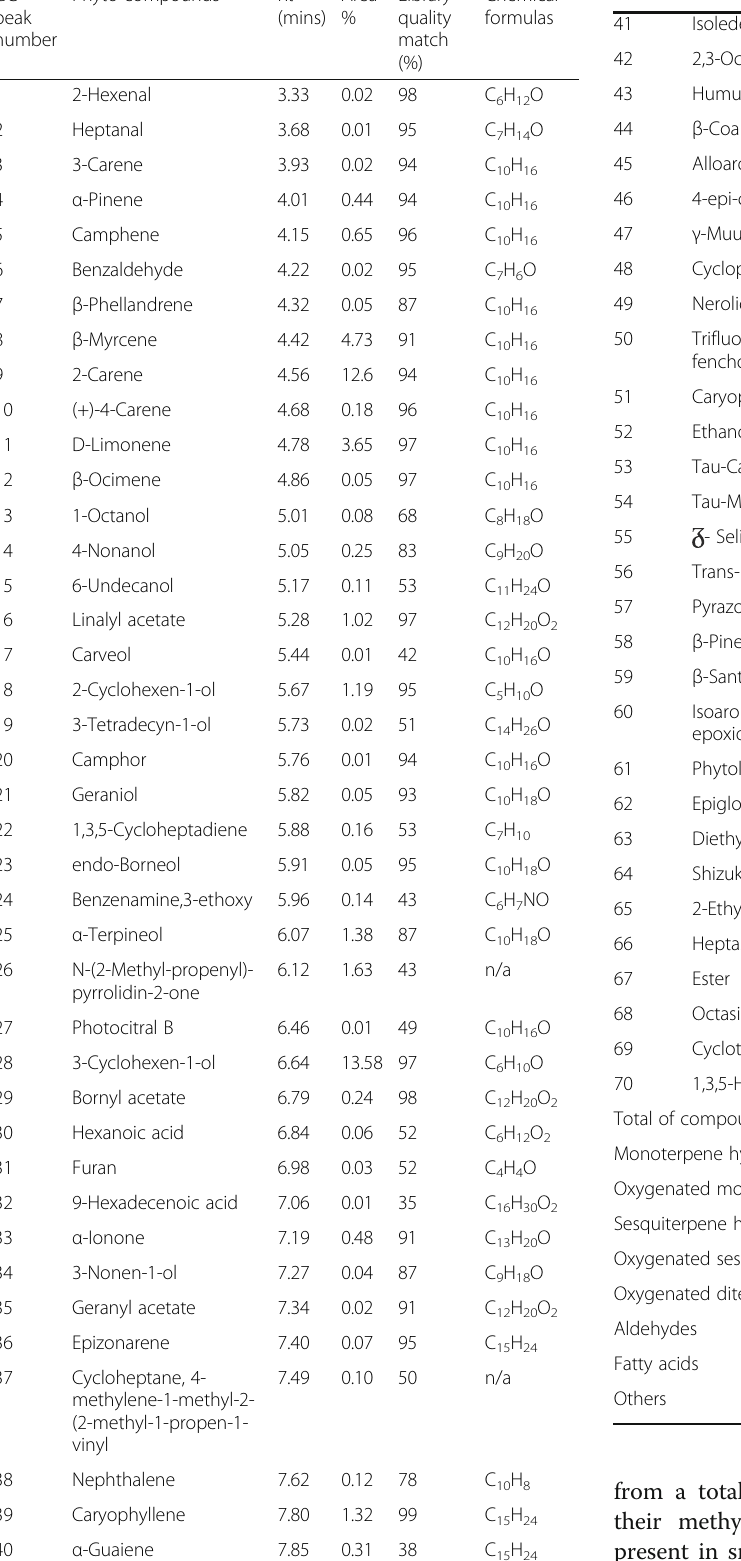
Table 3 Chemical compounds of Cymbopogon plurinodis